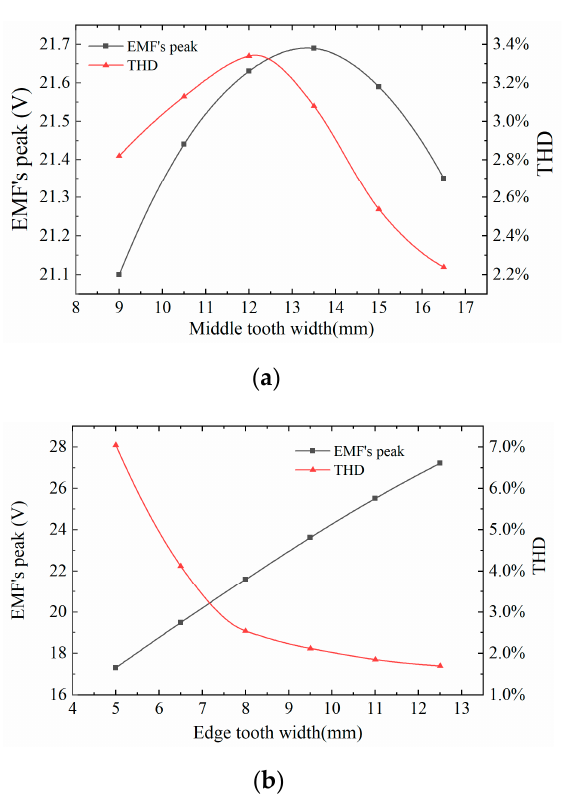
Figure 6. Effect of tooth width on EMF. ( a ) Middle tooth width; ( b ) edge tooth width.